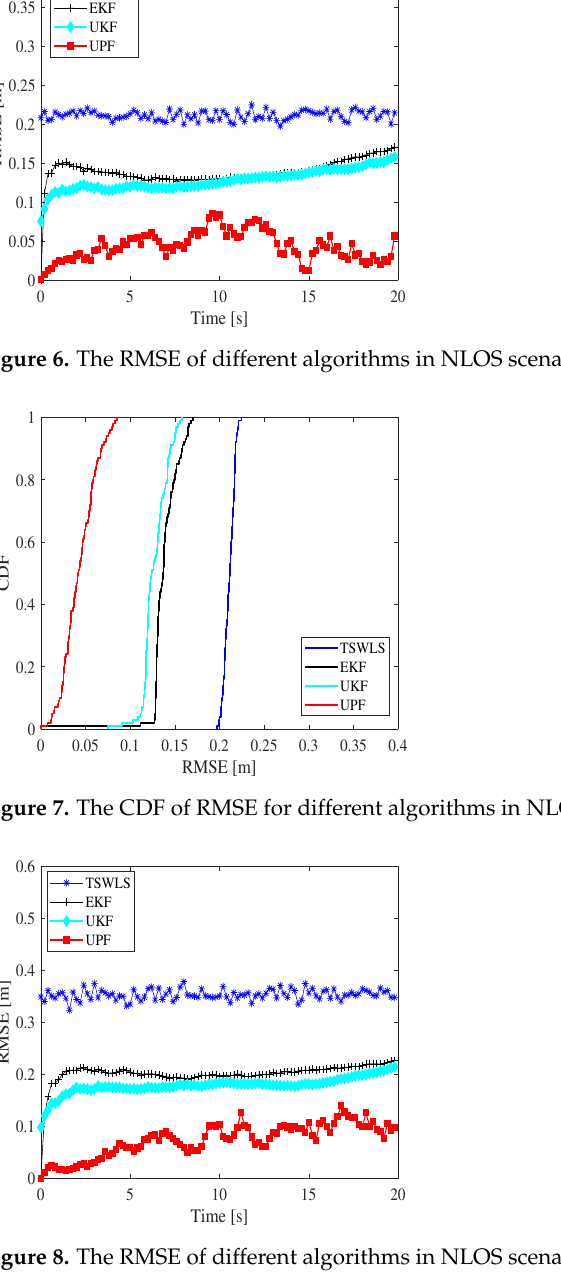
Figure 8. The RMSE of different algorithms in NLOS scenario ( σ θ Table 2 presents the statistical parameters of positioning error in NLOS